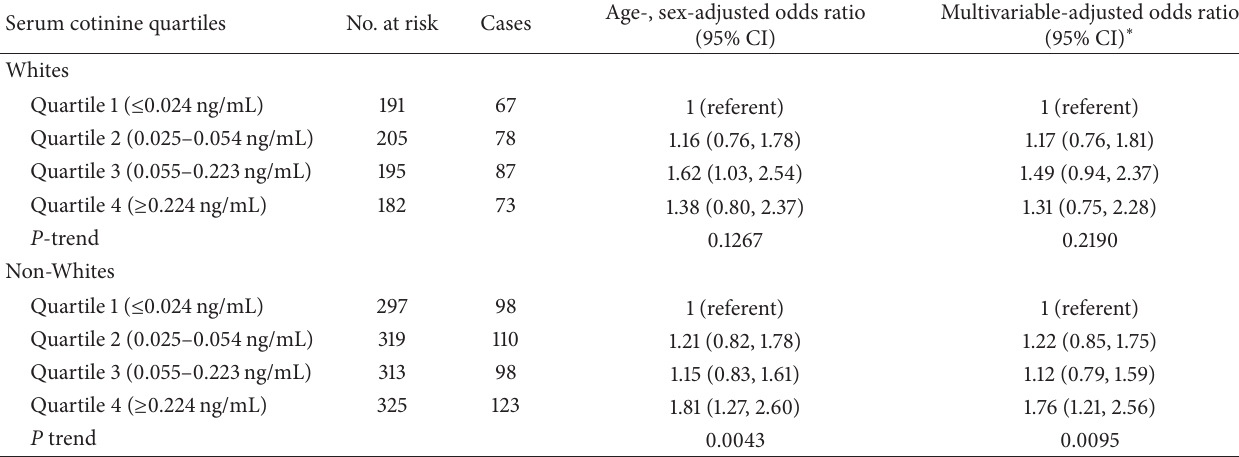
Table 4: Association between serum cotinine levels and prehypertension by ethnicity.